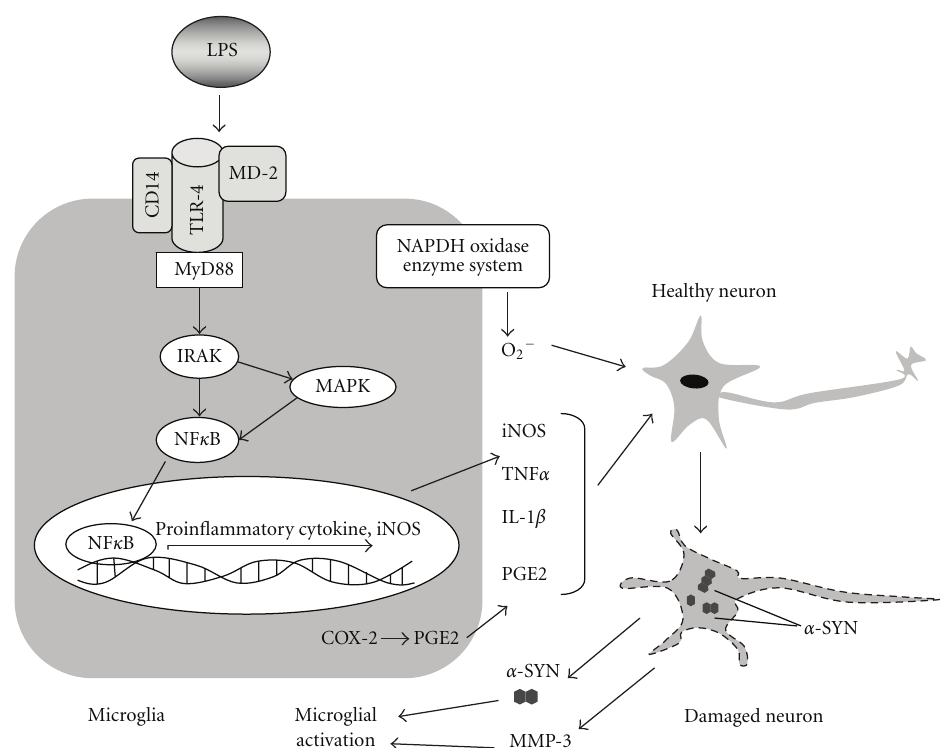
Figure 1: Simplified schematic representation of the link between LPS-induced microglial activation, inflammatory mediators, and dopaminergic neurodegeneration. Microglia respond to pathogens, proinflammatory cytokines, neuronal dysfunction, and cellular debris after injury or necrosis. These cells are at the forefront of the defence mechanisms that could set the conditions for repair or contribute to neuronal damage. Such equilibrium might depend on the expression and function of specific TLRs and howthey are activated by endogenous and exogenous ligands and signals. Recognition of such signals lead to transcriptional activation of innate immune genes. Bacterial endotoxin LPSis a potent stimulatorof macrophages, monocytes, microglia, and astrocytes causing release of various immunoregulatory and proinflammatory cytokines and free radicals. Neurons do not express functional TLR-4. Thus, LPS does not appear to have a direct e ff ect on neurons, making it an ideal activator to study indirect neuronal injury mediated by microglial activation [64]. LPS binds to its intermediate receptor CD14 and in concert with TLR4 and accessory adaptor protein MD2 triggers the activation of kinases of various intracellular signaling pathways. The MyD88-dependent cascade initiates NF κ B activation through the IKKs and/or the MAPK pathway, leading to the upregulated expression of proinflammatory cytokines (TNF α , IL-1 β ) and increased production of other inflammatory mediators (NO and PGE2, synthesized by iNOS and COX-2, resp.). These soluble mediators collectively damage nigral dopaminergic neuron. MMP-3 and α SYN released by stressed neuronsaggravate microglialactivation. Astrocyte, di ff erent activation states of microglia, peripheral immunecells, many molecules involved in intracellular signaling pathways, and crosstalk between TLR signaling pathway and NADPH oxidase enzyme system are not shown for the simplicity. Please see text for the abbreviations and the details of TLR signaling